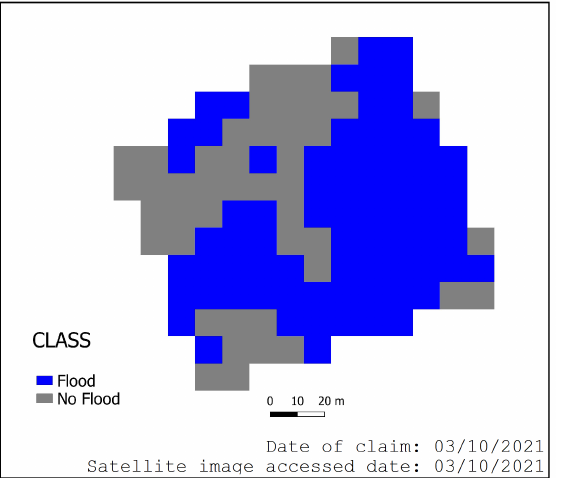
Figure 5. A sample of CART classification on Sentinel-1 SAR GRD image to verify the claim of the